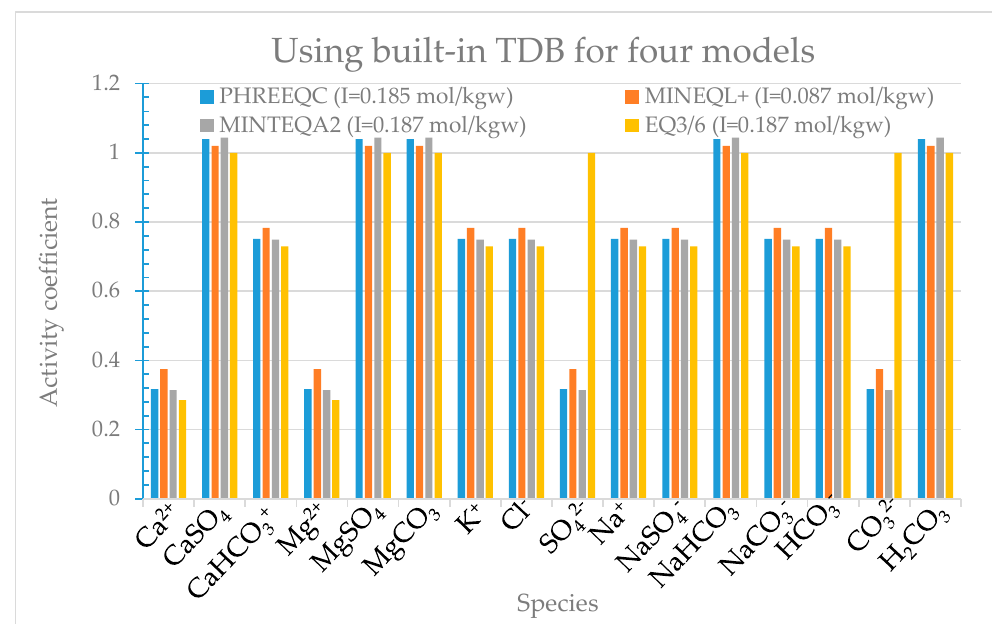
Figure 7. The solution concentration calculated by the Davies equation using the built-in thermody- namic database of the four models.